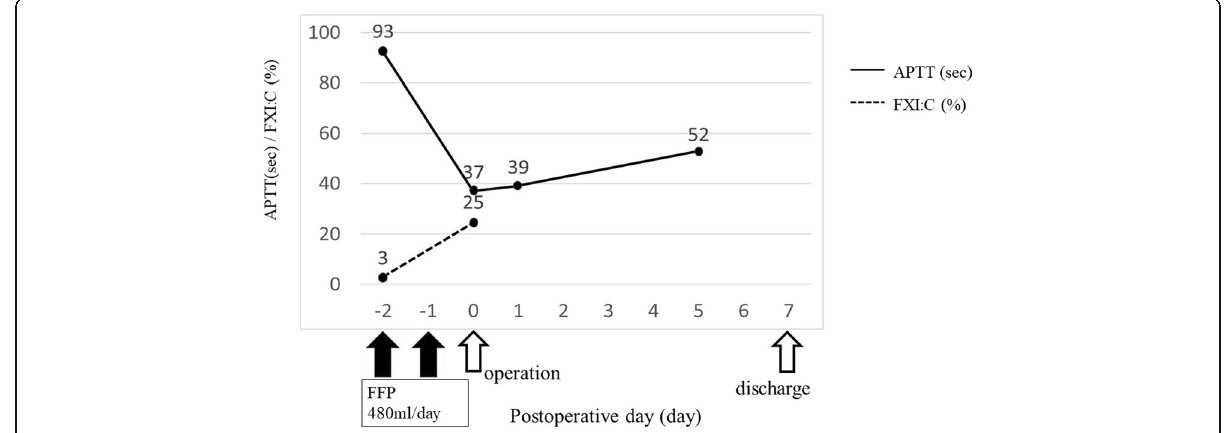
Fig. 4 Alterations in APTT and FXI: after transfusion, the APTT improved to 37 s, and FXI also increased from 3% to